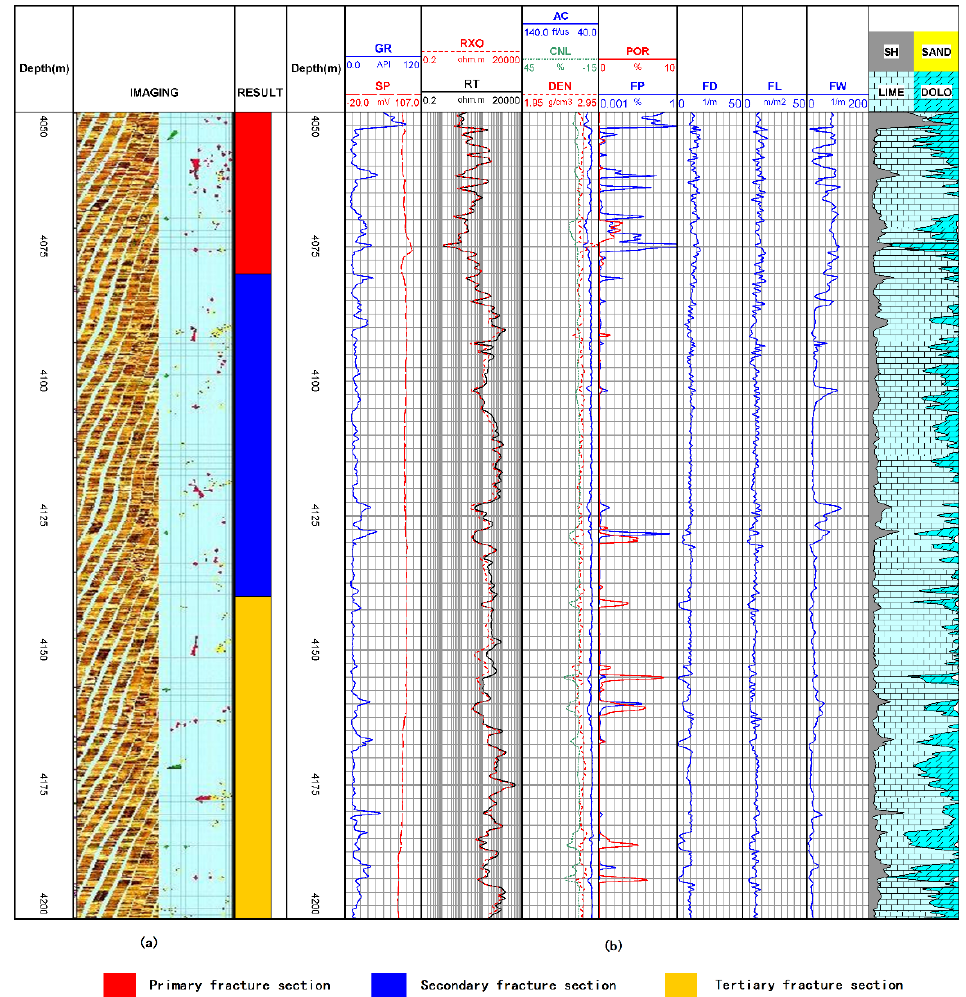
Figure 6. Comparison of fracture parameters between imaging logging fracture classification and conventional logging predictions in the Laopu Nan 1 well. ( a ) Natural Gramma, Natural potential and Imaging; ( b ) Conventional log.